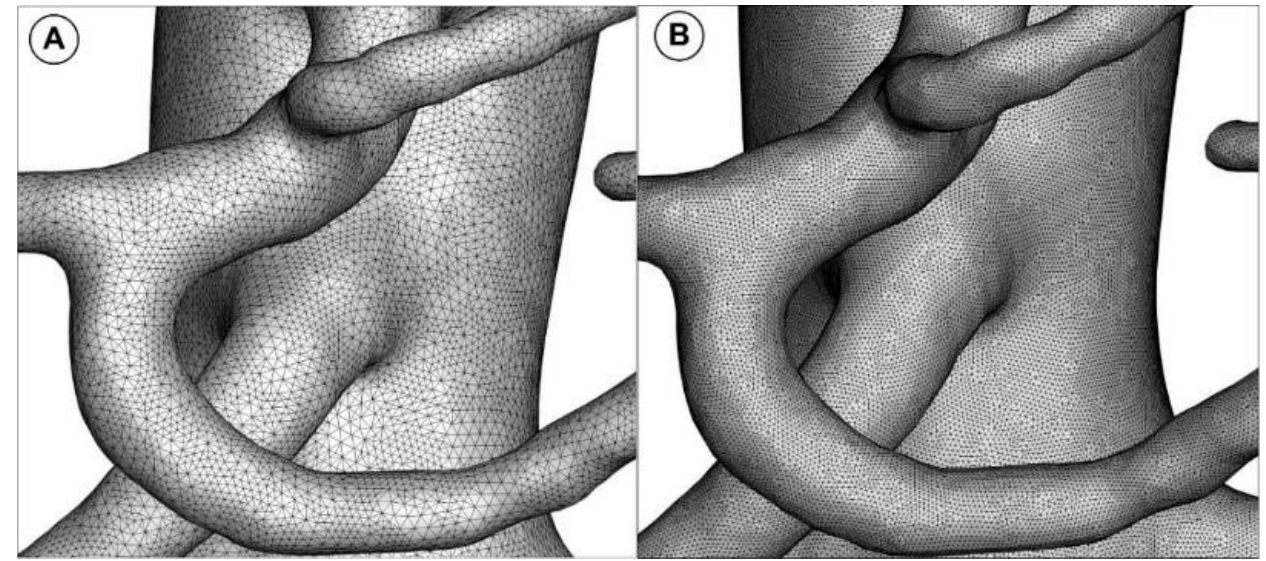
Figure 4. Unstructured v olumetric mesh generated for the arterial model numerical investigation. ( A ) coarse mesh (2,885,022 elements); ( B ) fine mesh (9,558,980 elements).